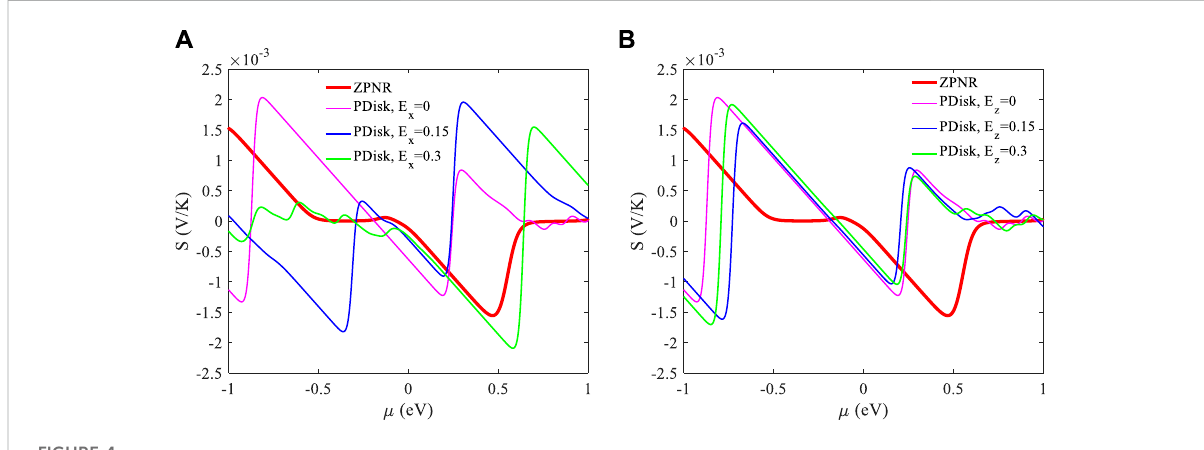
FIGURE 4 Seebeck coef fi cient behavior vs . chemical potential for the 12-ZPNR and various electric fi eld strengths applied along the (A) x -axis and (B) z -axis of the PDisk. Coordinate axes are shown in Figure 1. The temperature is 300 K. The unit for the electric fi elds is V/nm.